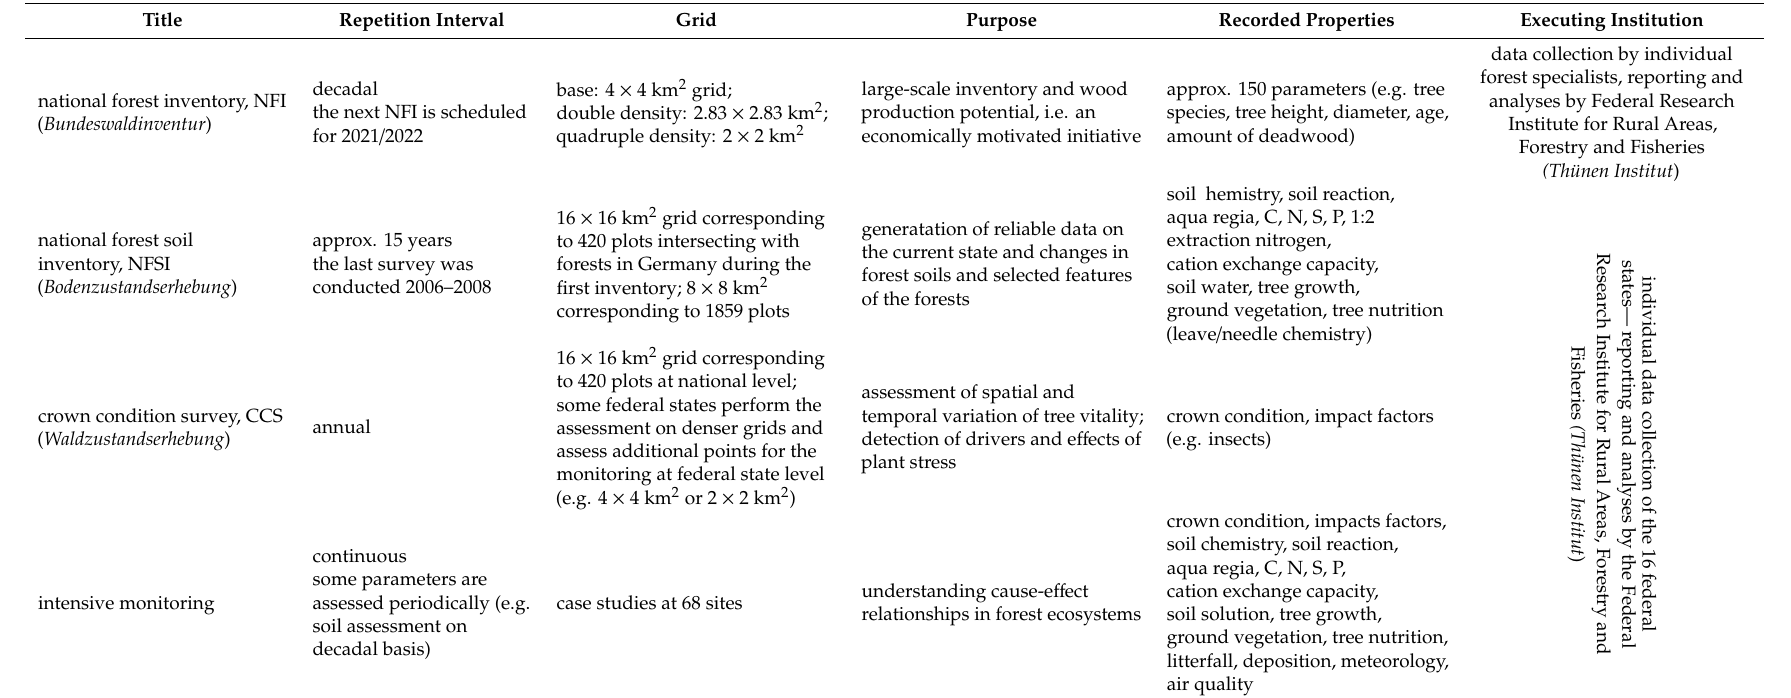
Table 1. Current forest monitoring and reporting practice in Germany (References